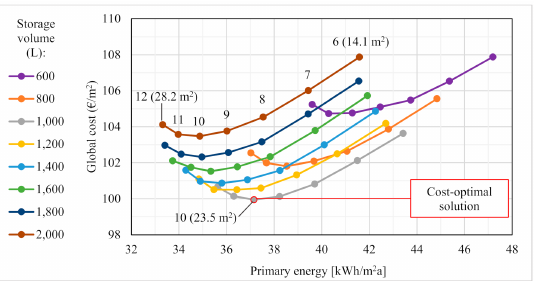
Figure 12. Solution curves of the solar thermal system depending on the volume of the storage tank (lines) and the number of solar collectors (dots), oriented south and set at a tilt angle of 35 ◦